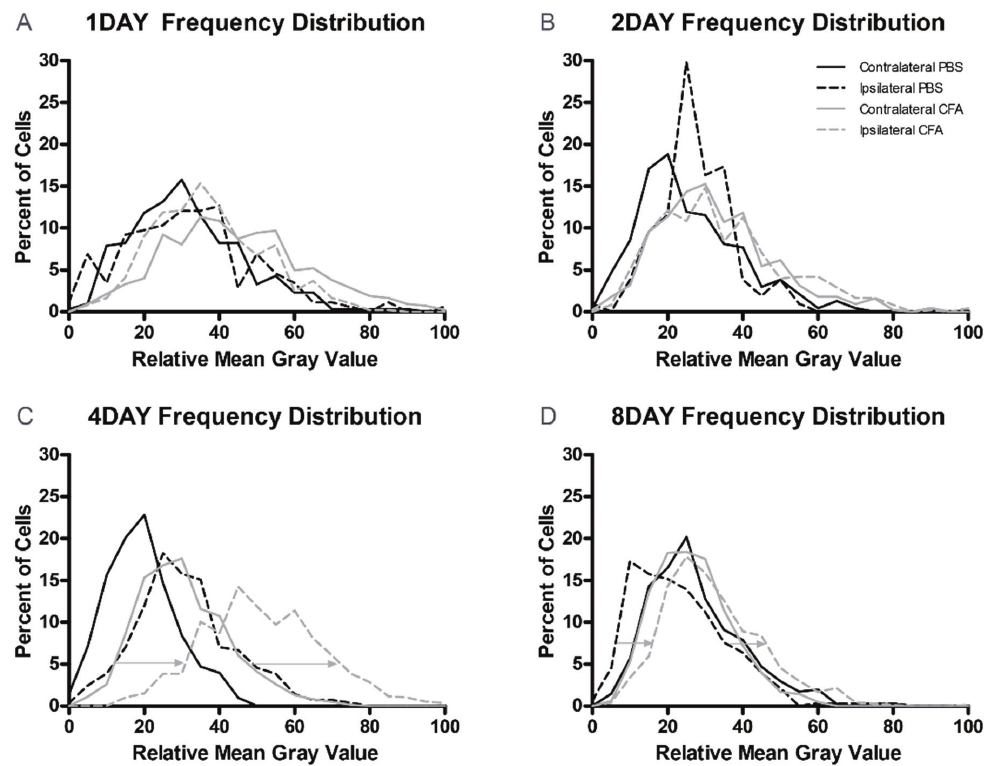
Figure 3. Frequency distributions for GLS-ir in L4 DRG neurons. ( A , B ) There were no obvious differences among the GLS-ir mean gray intensity (MGI) frequency distributions for ipsilateral or contralateral L4 DRG in PBS- or CFA-injected rats; ( C ) At day 4 AIA, there was a rightward shift (arrows) in the GLS-ir frequency distribution of the L4 DRG neuronal population ipsilateral to the CFA injection compared to the ipsilateral PBS injection; ( D ) At day 8 AIA, a slight right shift (arrows) remained in the GLS-ir frequency distribution of the L4 DRG neuronal population ipsilateral to the CFA injection compared to the ipsilateral PBS injection.